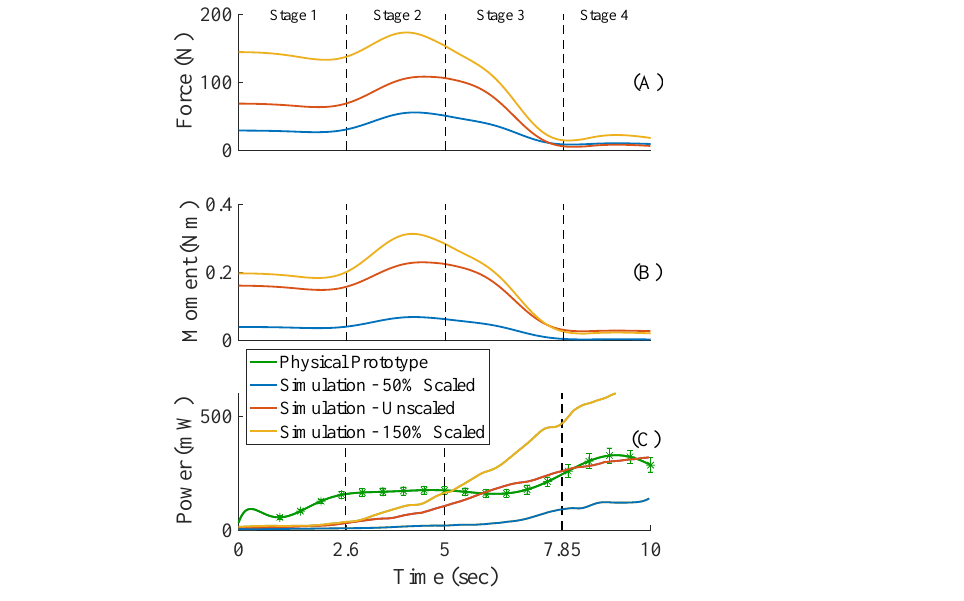
Figure 6. ( A ) Applied forces from all the active elements on the simulated model at varying sizes (50%, 100%, and 150% scales) show that a smaller model requires similar amounts of forces to replicate the four stages of gait. ( B ) Simulated moments (N · m) on the hip joint throughout the four stages of gait estimate the required actuators. ( C ) Power consumption (mW) of the structure is similar to the simulation and the physical prototype performing the four stages of gait. The average of the few trials (solid green line) for the physical prototype created the upper and lower error bars. As we enlarge the model size, the forces necessary to produce the same motion increase. Increasing the size of the simulated models demonstrated a significant spike in overall energy consumption. It is worth noting that the 100% scaled simulation model is the same size as the physical prototype.